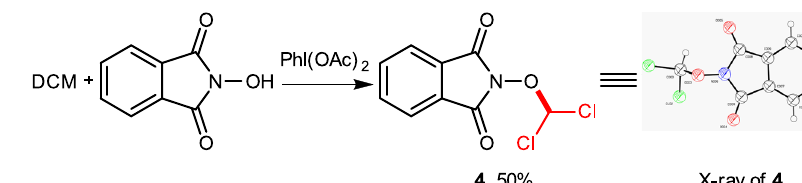
Fig. 2 Reaction of DCM with NHPI. DCM as both the solvent and the